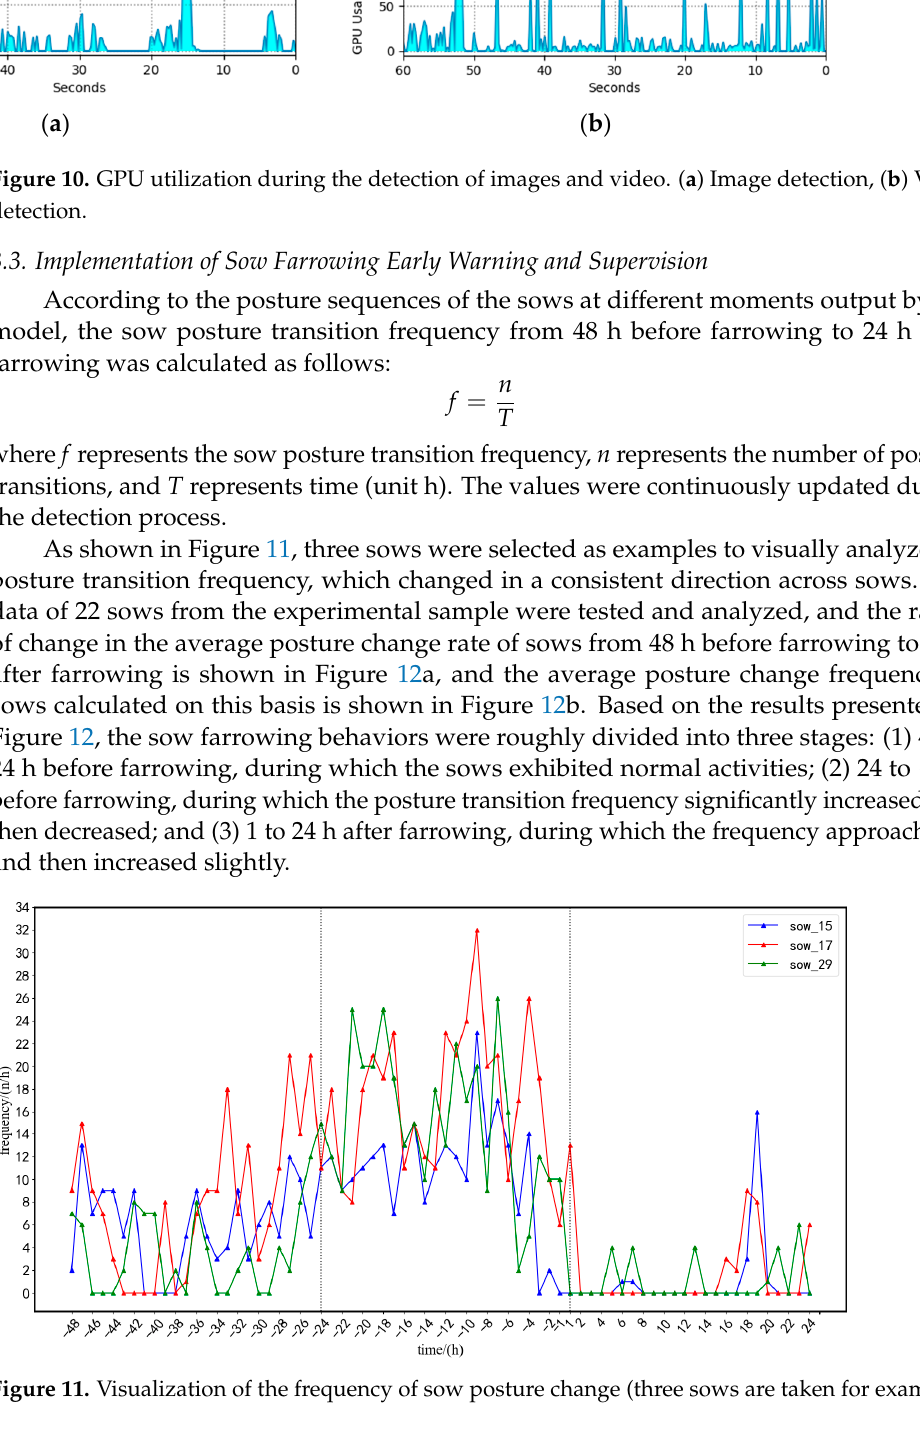
Figure 10. GPU utilization during the detection of images and video. ( a ) Image detection, ( b ) Video